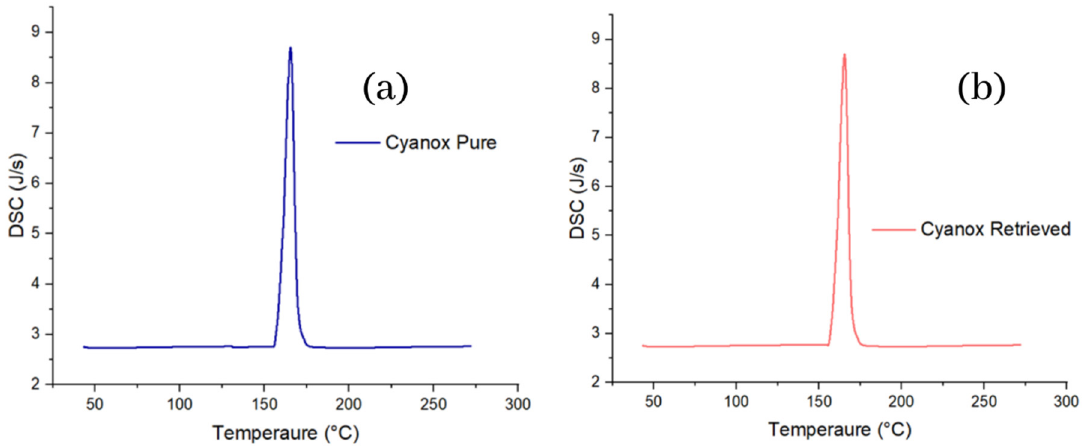
Figure 6. DSC charts for pure ( a ) and recovered ( b ) Cyanox 1790.